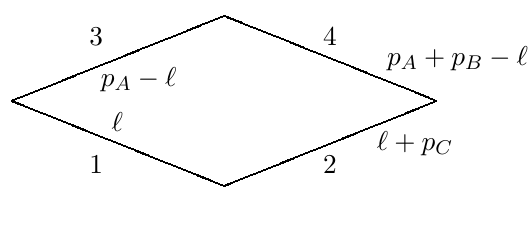
Figure 2 . The reduced diagram of (cid:12)gure 1 associated with R when at the pinch all propagators are nearly on-shell and the energies carried by the propagators lie in the range (3.8). The internal lines are drawn in a way so that at the pinch energy (cid:13)ows from the left to the right along each of the propagators. Since four propagators become on-shell at the pinch, the pinched subspace has comension 4, and R is a small neighborhood of this codimension 4